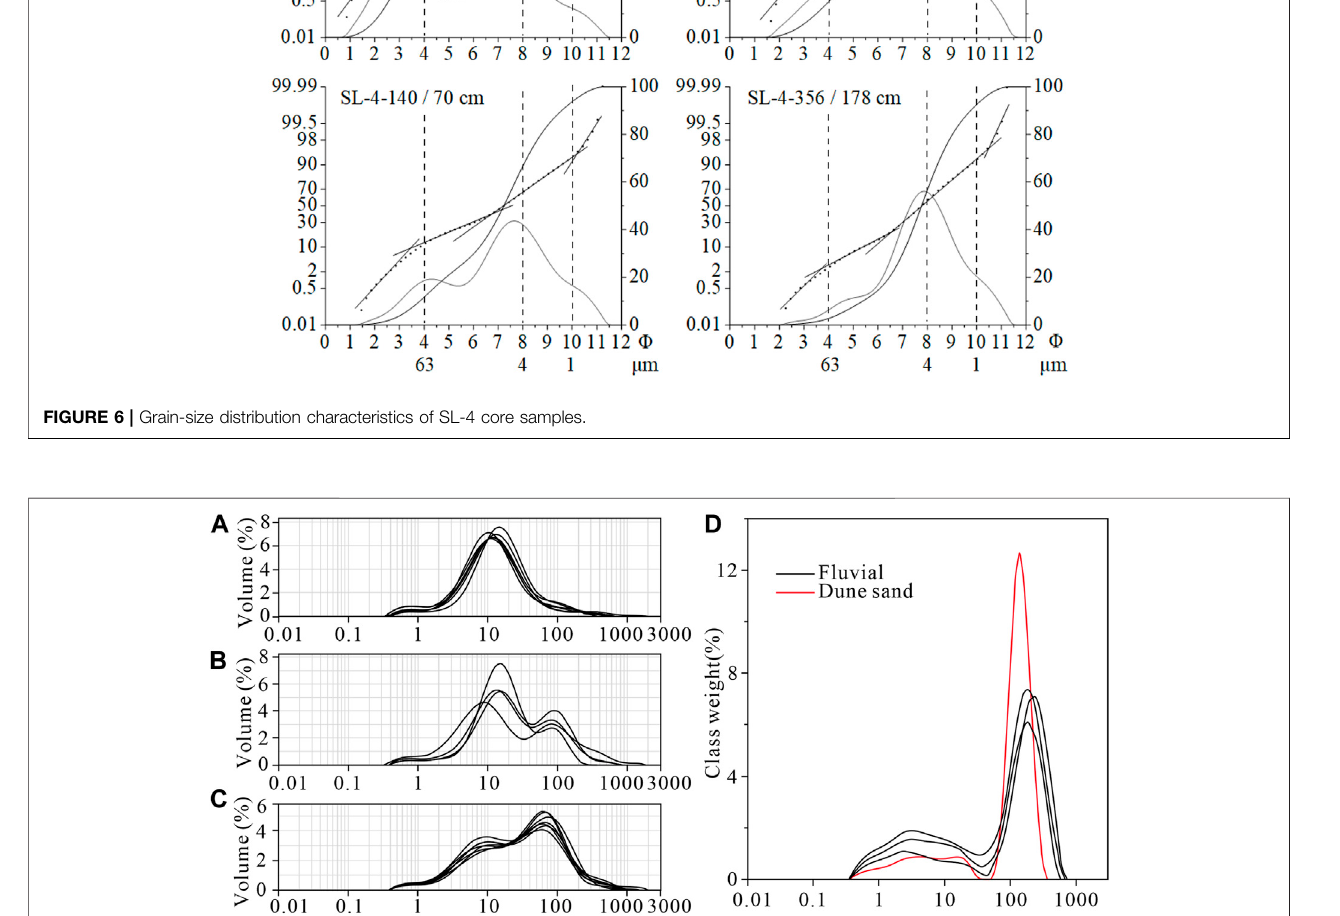
FIGURE 7 | Frequency distribution curves of grain size for the surface samples. (A) Lake surface sample sites are far away from the shore (Wang et al., 2019). (B) Lake surface sample sites with water depth < 32.6 m or offshore distance < 3.9 km (Wang et al., 2019). (C) Ice-trapped aeolian dust (Wang et al., 2019). (D) Catchment fl uvial sand and dune sand (Hou et al.,